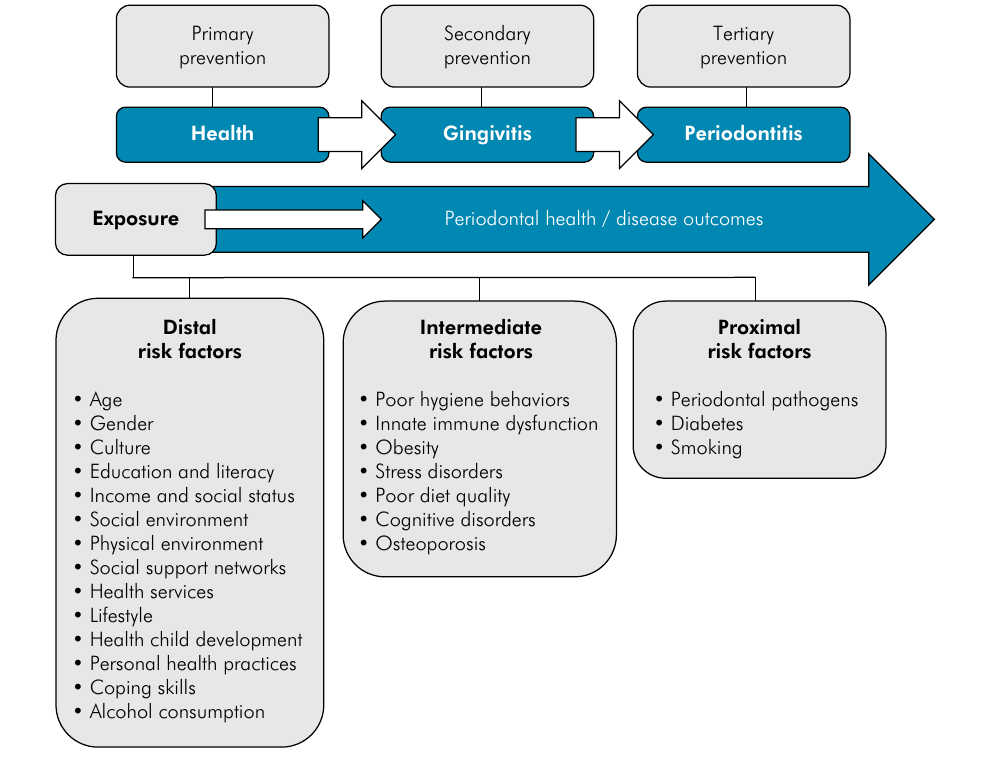
Figure 1. Periodontal risk factors. Adapted from Bouchard et al.